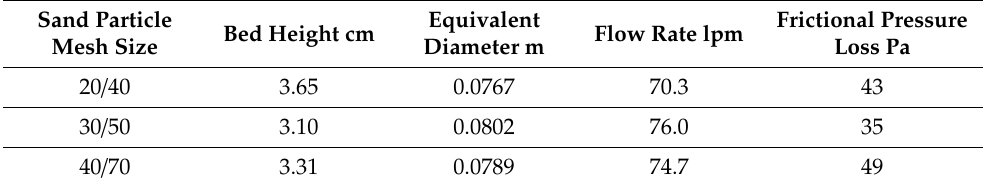
Table 2. Frictional pressure drop measured at 0.25 m / s superficial velocity.